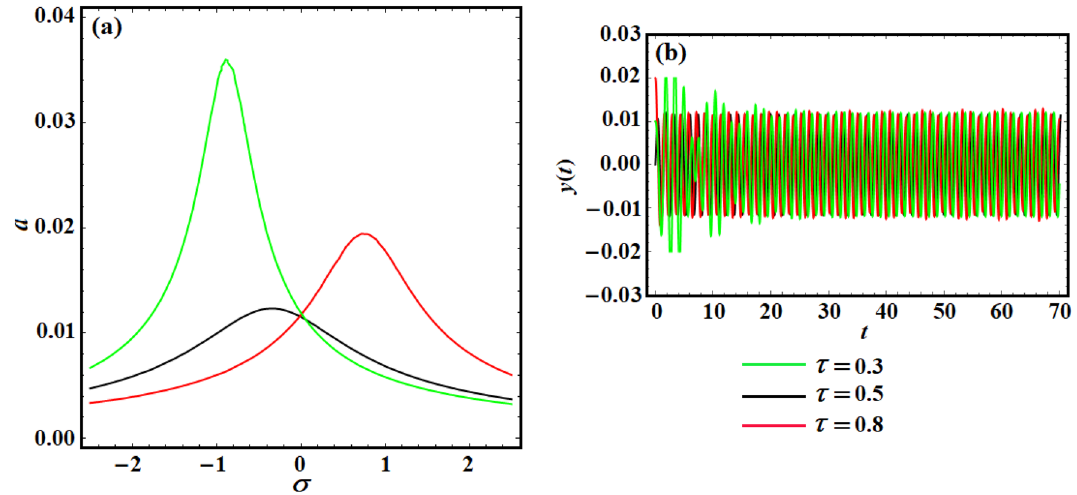
Figure 12. ( a ) Represents the system frequency–response curves at γ = 2, (cid:31) = 0.8, F = 0.1 for various amounts of the time-delay parameter, and ( b ) shows the system time response, when γ = 2, (cid:31) = 0.8